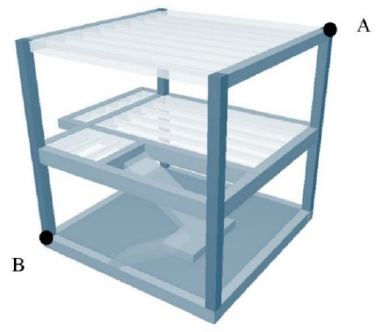
Figure 10. Model sketch III. Figure 8. Model sketch I. Figure 8. Model sketch I.